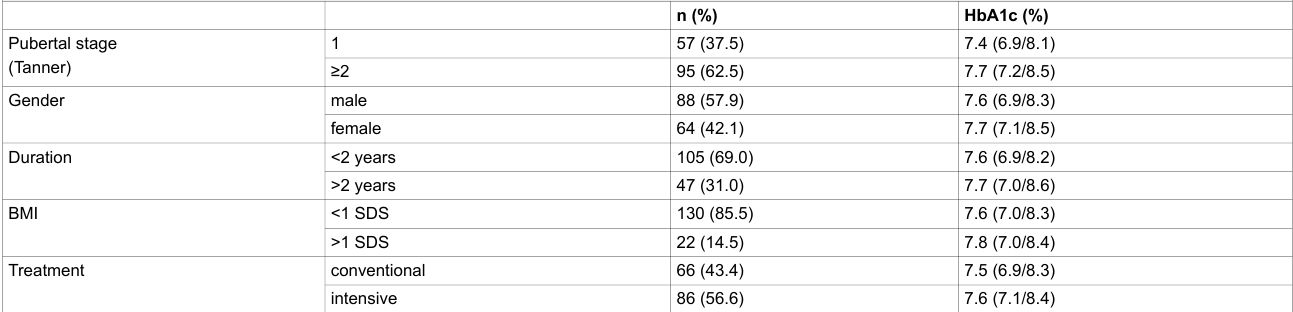
Table 1 Clinical data, grouped by the pubertal stage, gender, diabetes duration, Body Mass Index and treatment modality, expressed as median (25 th /75 th